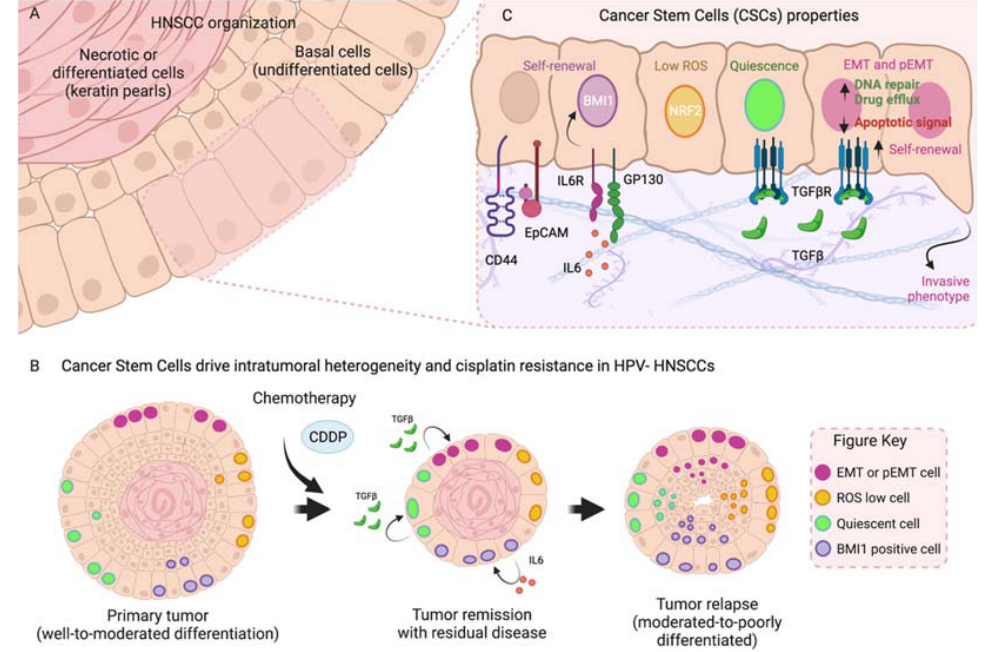
Figure 2. HNSCC CSCs’ characteristics and their role in cisplatin resistance and tumor relapse. ( A ) HNSCCs resemble the architecture of an epithelial tissue, with a basal layer enriched in prolif- erative cells, potentially containing CSCs. Basal cells give rise to differentiated cells that ultimately form terminally differentiated keratin pearls or necrotic regions. ( B ) HNSCCs present intra-tumoral heterogeneity, containing CSCs pools with different properties, which increases the chances of persist- ing after cisplatin treatment. CSCs surviving after chemotherapy could repopulate the affected zone causing tumor relapses that are usually poorly differentiated. ( C ) CSCs’ properties include increased self-renewal promoted by IL-6-induced BMI1 expression, enhanced ROS detoxification driven by NRF2 overexpression and the induction of quiescence or mesenchymal programs through TGF β . Created with